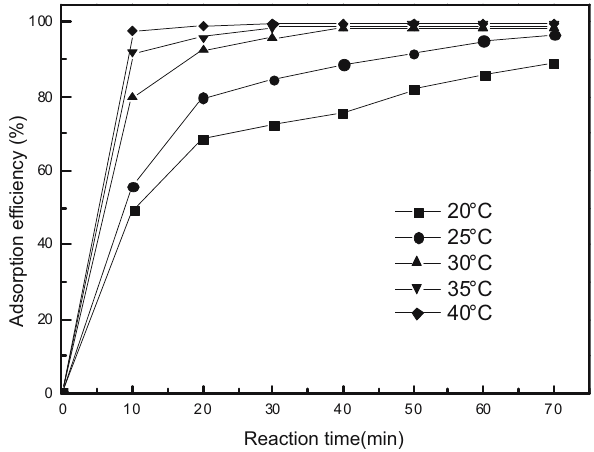
Figure 3: E ff ect of temperature on the adsorption e ffi ciency for GPC by 001 × 7 cation - exchange